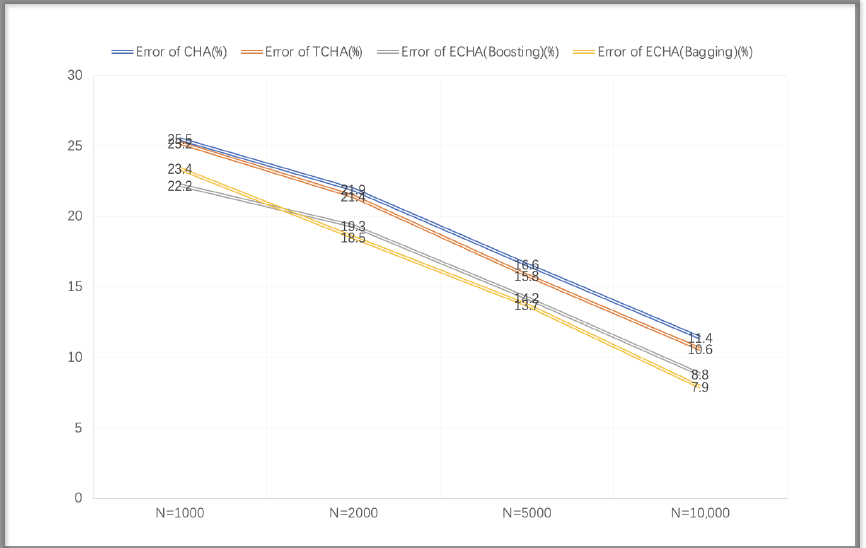
Figure 6. The error rates of different classifiers for the 4-qubit case when N increased. They were slightly poorer than those for the 3-qubit